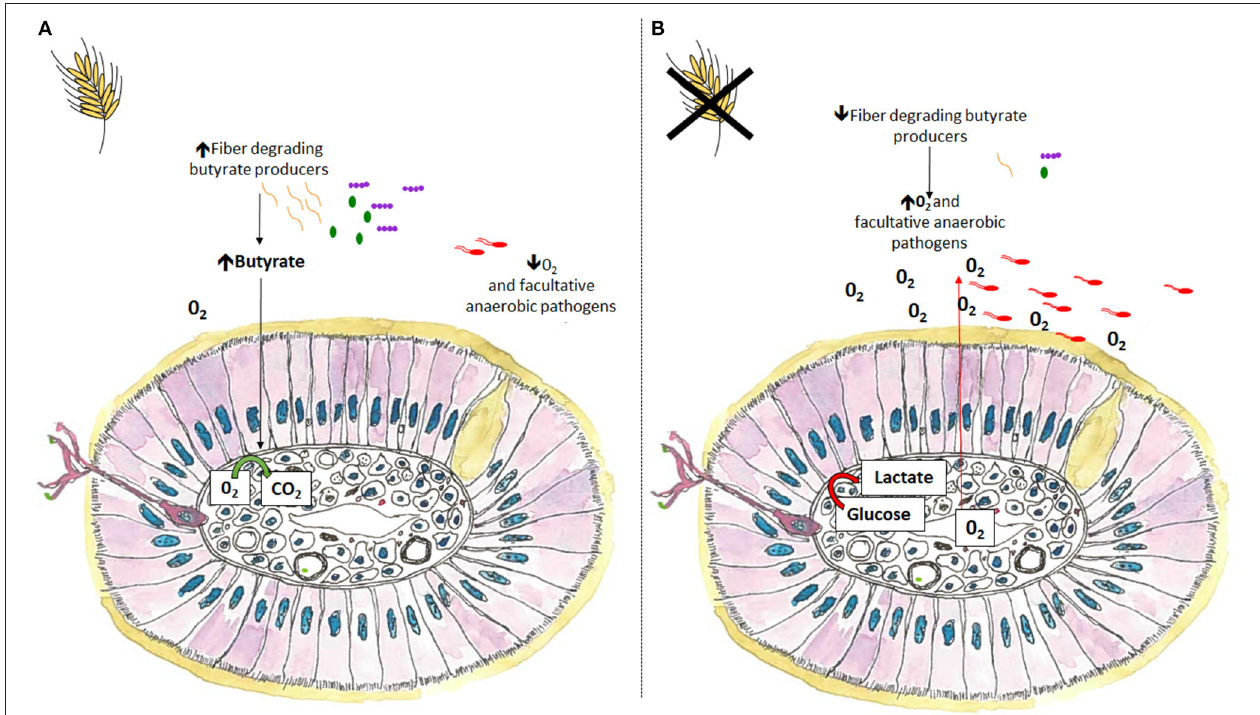
FIGURE 3 | A transverse cross section of colonic villi in the presence or absence of dietary fiber. (A) Inclusion of dietary fiber helps maintain intestinal homeostasis and improves disease resilience by maintaining a hypoxic environment. Dietary fiber facilitates the expansion of anaerobic butyrate producers, which subsequently increases butyrate concentrations, reducing luminal oxygen, and limiting the expansion of facultative anaerobic pathogens. (B) Alternatively, in the absence of dietary fiber facultative anaerobic pathogens, including certain E. coli and Salmonella species may expand at the expense of oxygen sensitive butyrate producers. In the absence of butyrate, enterocytes use anaerobic glycolysis to obtain energy, a process that increases epithelial oxygen concentrations creating a favorable niche for facultative pathogens such as Salmonella to